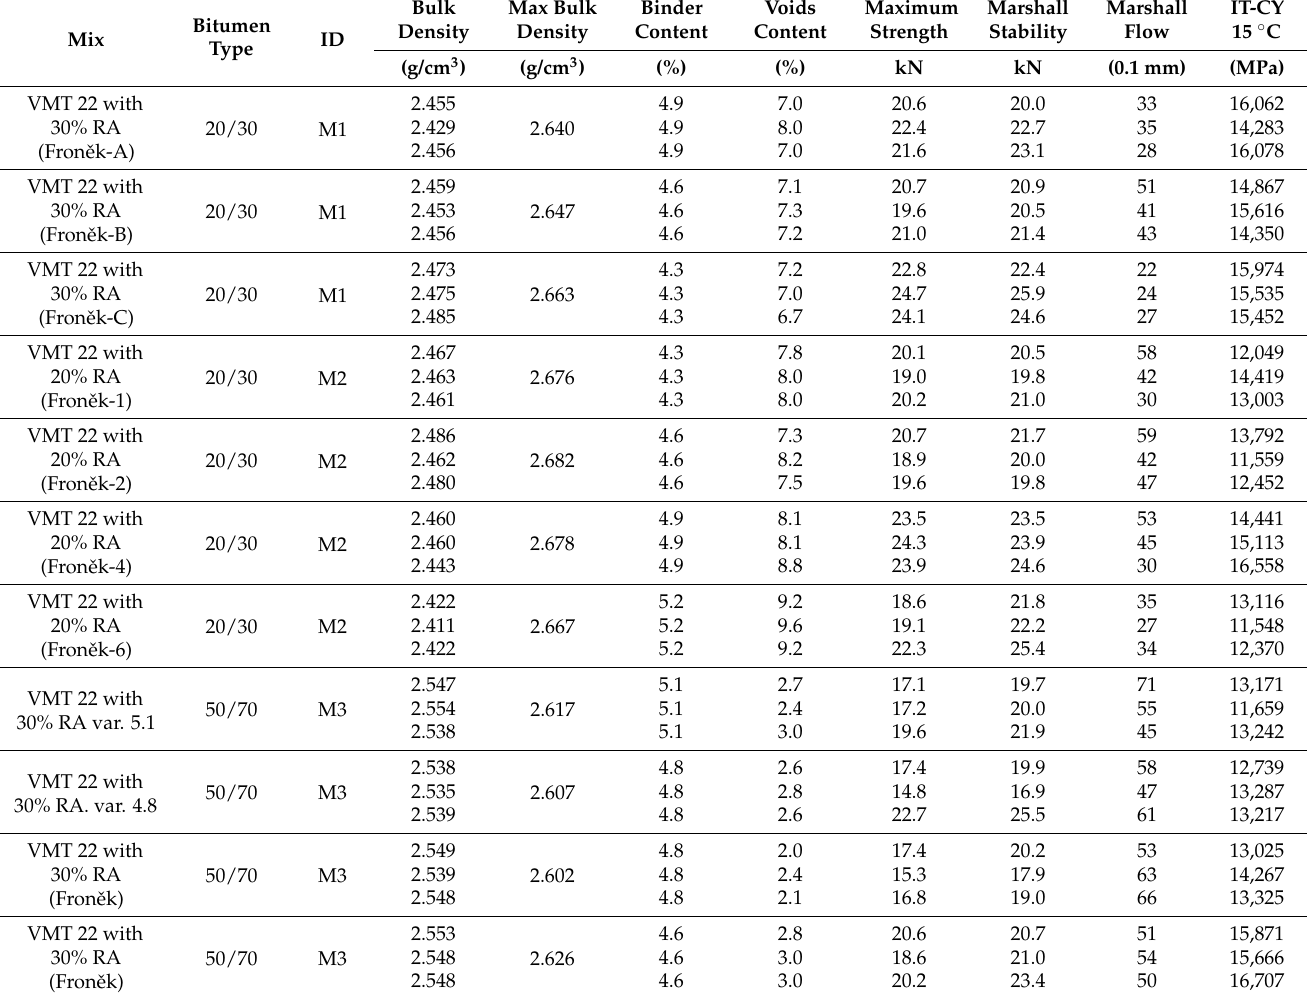
Table 1. Summary of experimental test results and specimens’